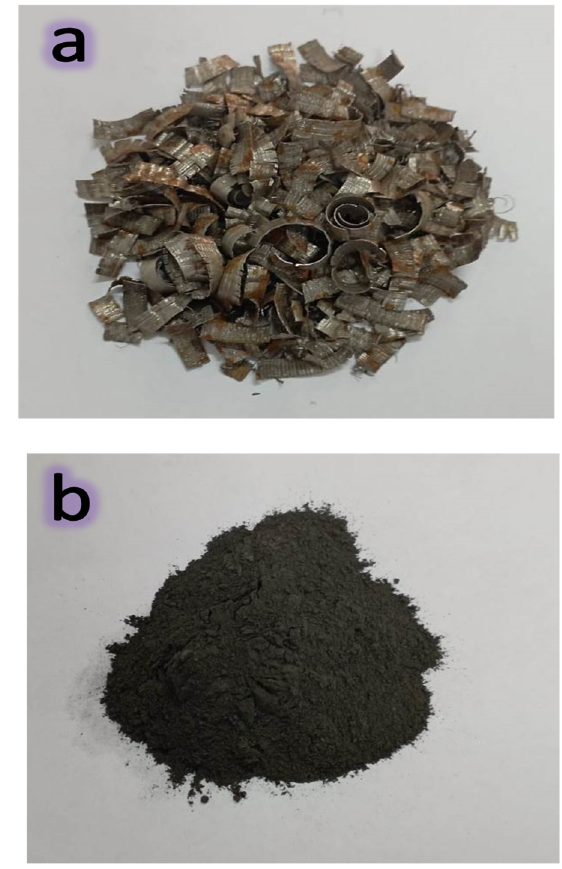
Figure 1. Photographs of Fe waste ( a ) before and ( b ) after milling for 3 h. The XRD patterns of the raw materials, i.e., Fe, Cu, NbC and granite powders, are shown in Figure 2a,b. According to (ICCD file cards: 89-4185, 85-1326 and 89-3830), respectively, the patterns show the existence of peaks corresponding to Fe, Cu, NbC, and granite. Since granite consists of three phases; namely quartz (SiO 2 ), albite (Na(AlSi 3 O 8 )) and annite (KFe 32+ AlSi 3 O 10 (OH)) 2 , it should be identified according to the presence of the characteristic XRD peaks of these components (ICCD file cards 88-2487, 89-6430 and 42-1413, respectively).